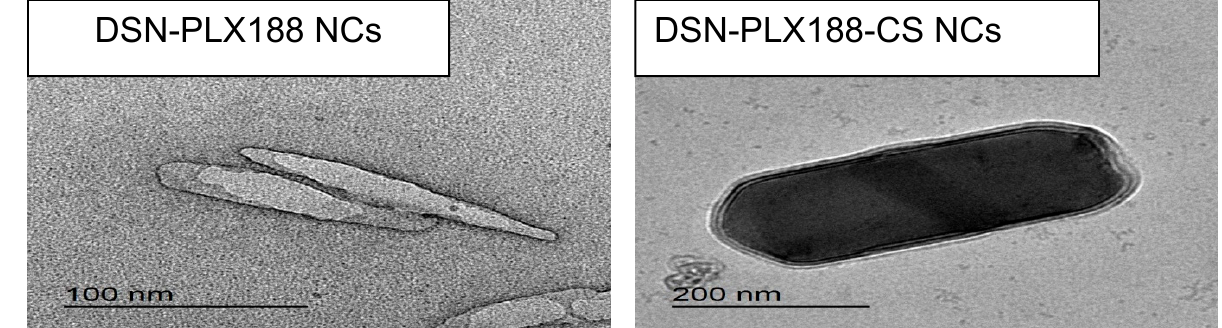
Figure 2. TEM microphotographs of the selected DSN NCs.